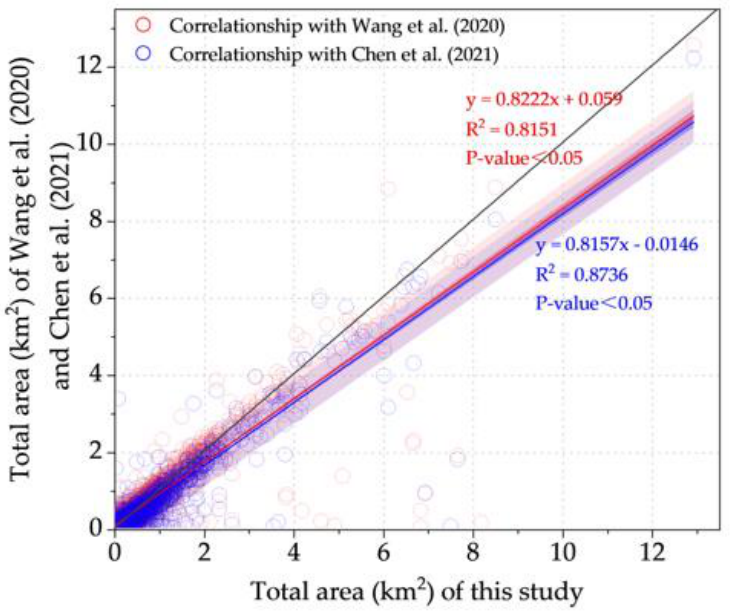
Figure 10. Total area correlation of our inventory with Wang et al. [15] and Chen et al. [30], respectively. The red and blue lines are the correlation fitting curves with each of them, and the black line is the 1:1 diagonal line.